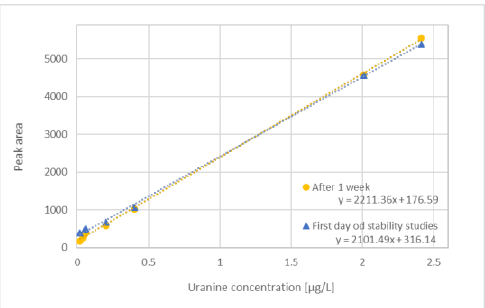
Figure 5. Results obtained when evaluating the stability of standard solutions subjected to extraction (measurements taken immediately after extraction and one week after extraction using SPE).